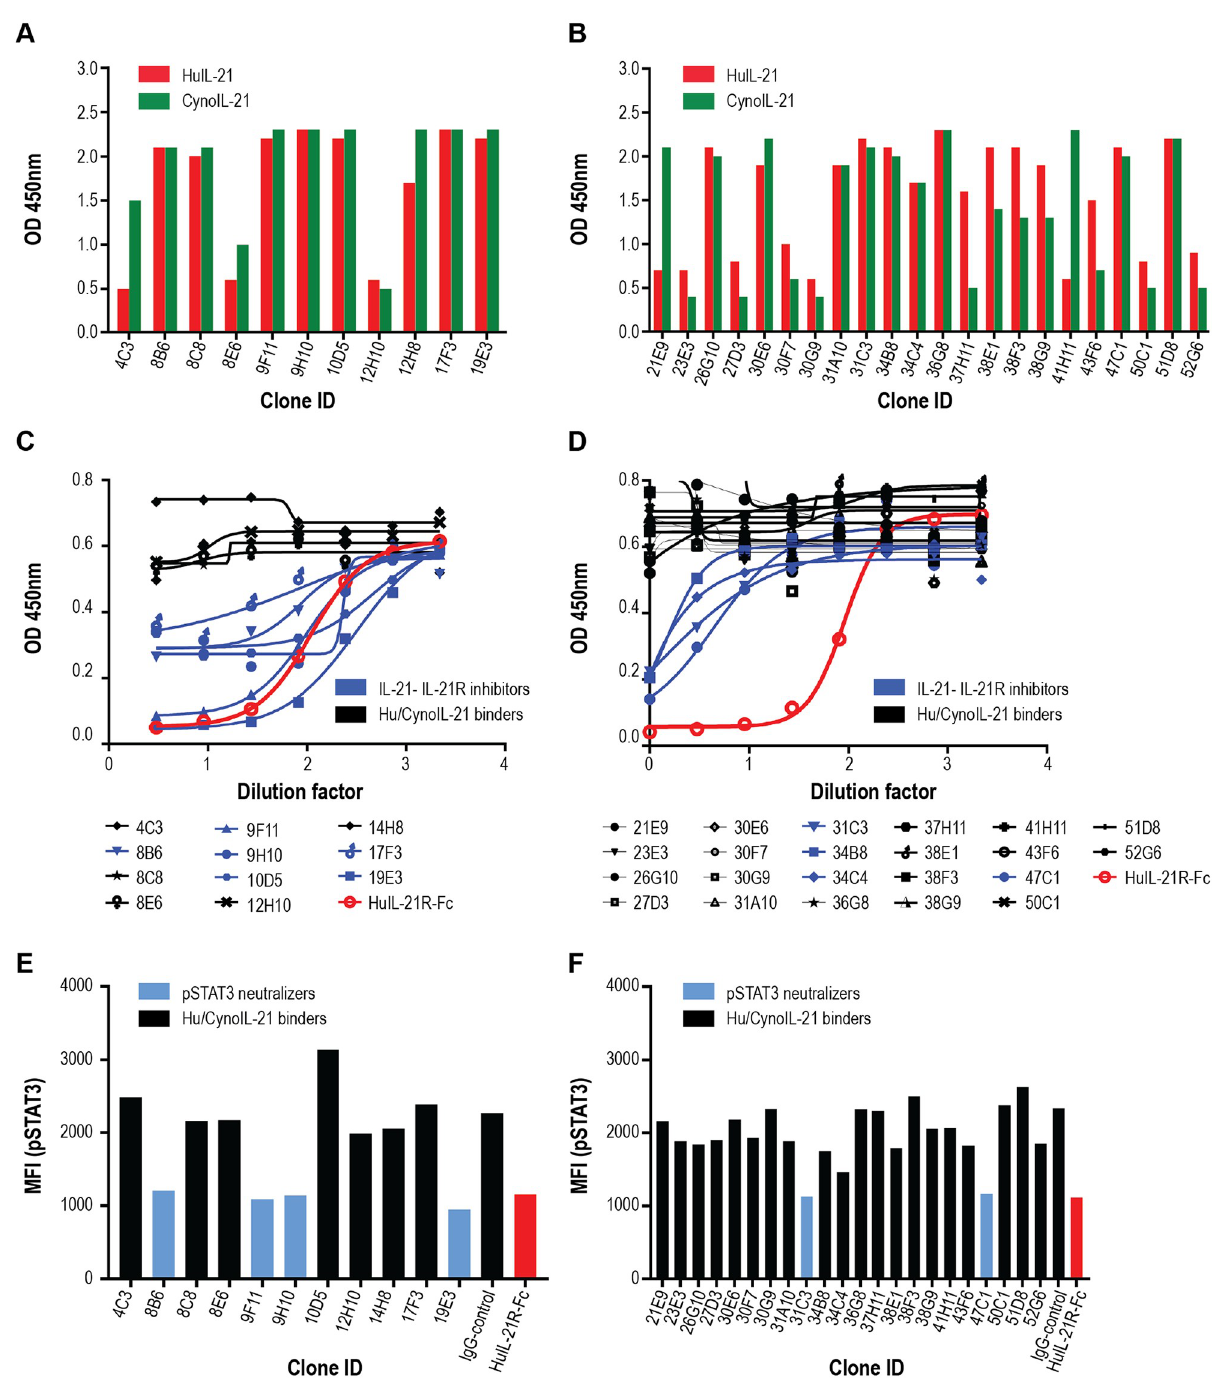
Fig 2. More efficient generation of neutralizing hybridomas against IL-21 from the alternating-antigen approach. (A, C, and E) hybridomas isolated from the alternating antigen approach. (B, D and F) hybridomas isolated from the single antigen approach. (A, B) Binding ELISA results of human and cyno IL-21 cross-reactive hybridoma supernatants. (C, D) Cross-reactive hybridoma supernatants were tested for their ability to inhibit the human IL-21/IL-21R-Fc interaction in a competition ELISA. Numbers on the x-axes are the dilution folds in log scale. The red lines represent the inhibitory activity displayed by IL-21R-Fc and are included for comparison. OD = optical density. (E, F) All cross reactive hybridoma supernatants were also tested for their ability to inhibit IL-21-induced phosphorylation of STAT3 and were assessed by flow cytometry. The red bars represent the neutralizing activity exhibited by soluble IL-21R-Fc blocking the IL-21 interaction and are included for comparison. Light blue bars denote anti-IL-21 clones which neutralize STAT3 phosphorylation.